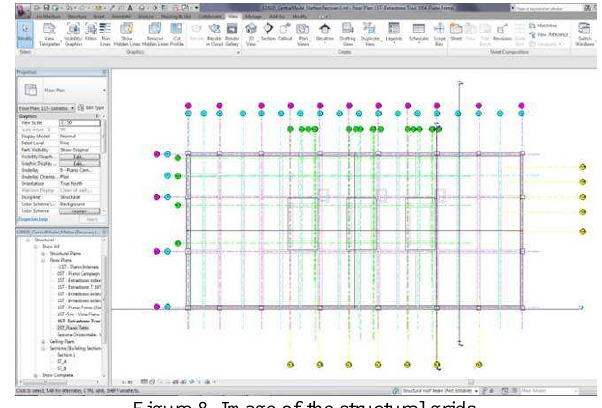
Figure 8. Image of the structural grids.